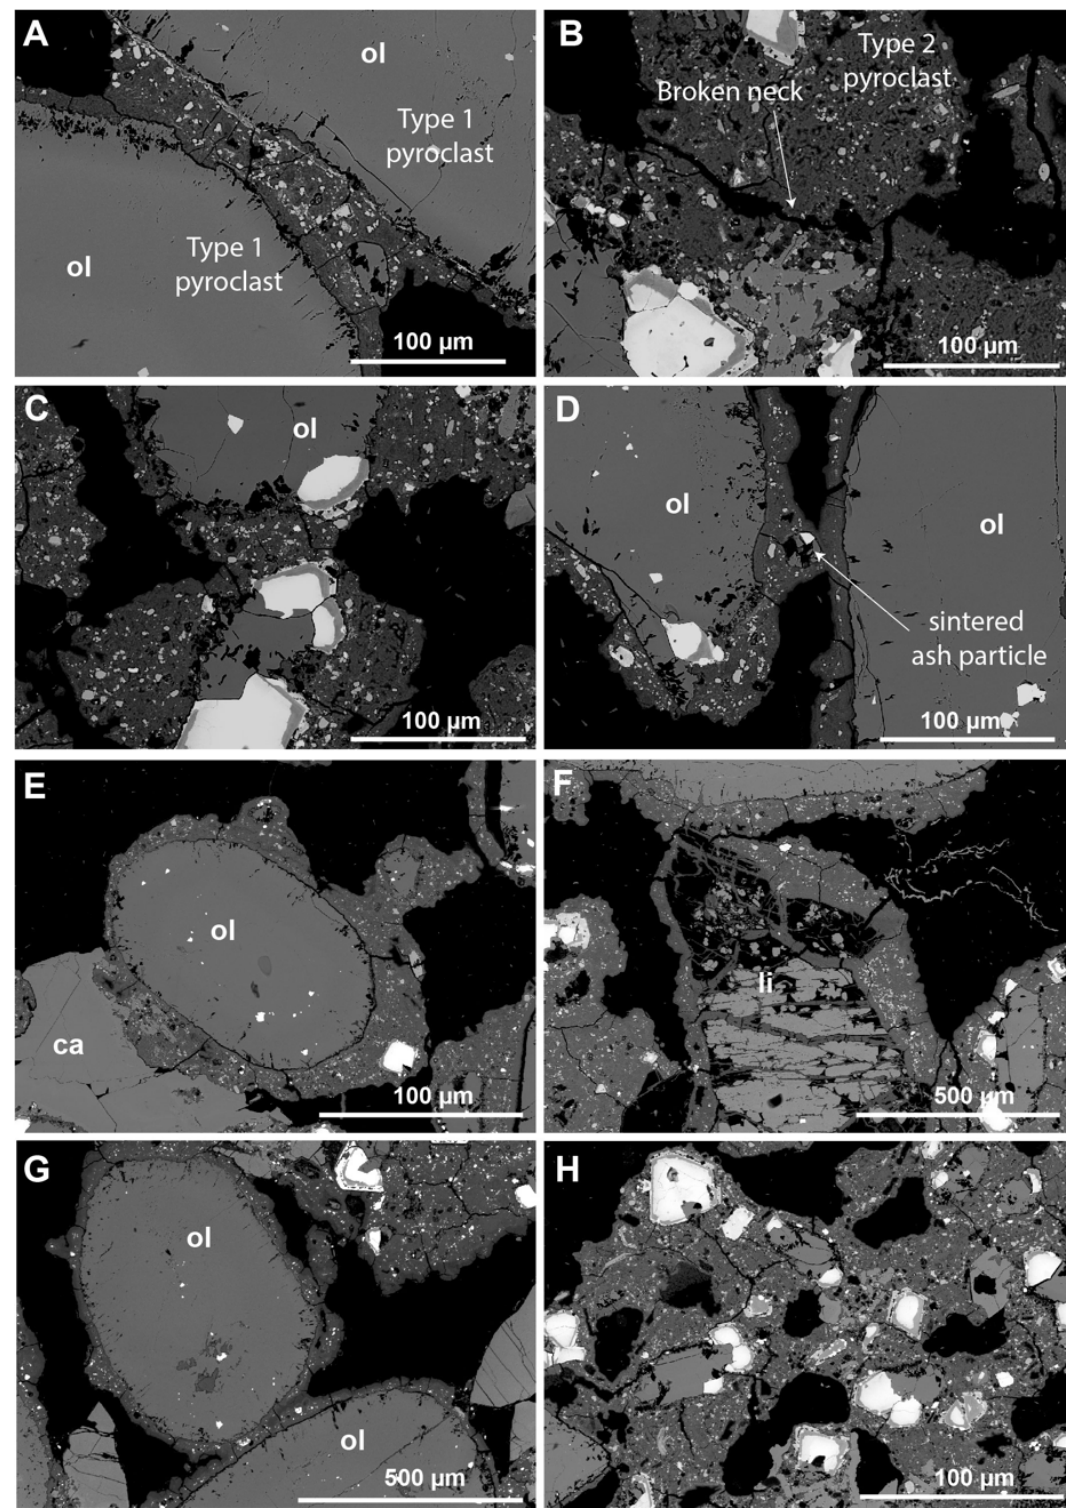
Figure 4: Examples of agglutinated pyroclasts. [A] Agglutinated neck between two groundmass coated olivine crystals (Type 1 pyroclasts). [B] Broken neck between two Type 2 pyroclasts. [C] Agglutinated neck between two Type 1 pyroclasts. [D] Thin agglutinated neck between two Type 1 pyroclasts (i.e. olivine crystal). [E] Type 1 pyroclasts with small agglutinated clasts on exterior and post-eruption calcite cement (ca). [F] and [G] Examples of thin agglutinated necks between pyroclasts. Lithic clast forms the core in the Type 1 pyroclast in [G]. [H] Type 2 pyroclast with small irregular vesicles. Bright white crystals are titanomagnetite with spinel rims [see Willcox et al.